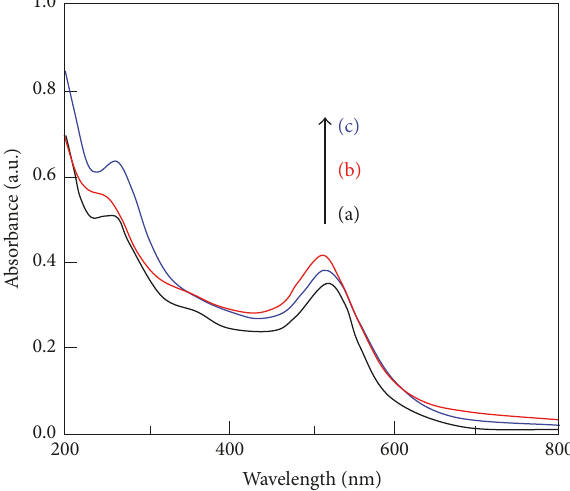
Figure 5: UV-Vis spectra of AuNPs/dextran solutions fromdifferent dextran concentrations: 0.5 (a), 1.0 (b), and 2.0% (c).